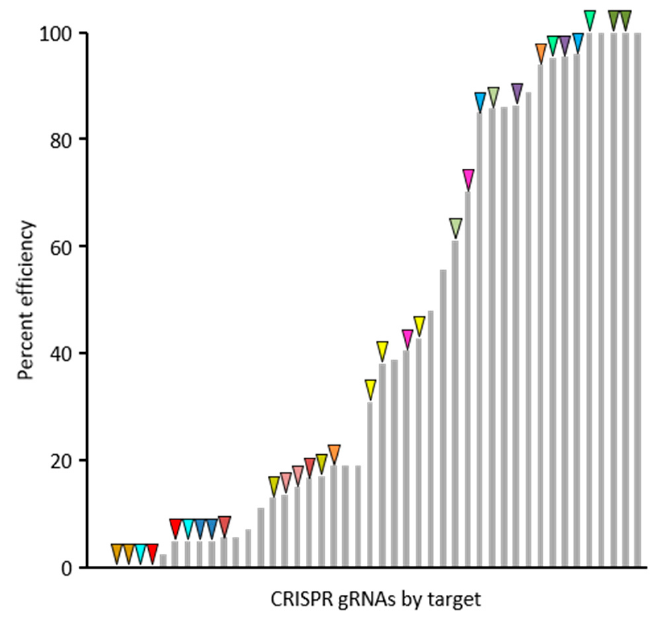
Figure 2. Efficiency rates of 30 gRNAs in maize. The proportion of target alleles edited in T 0 plants varies widely by gRNA and target, though the distribution of efficiency rates is skewed towards the extremes, with 39% of gRNAs tested having less than 15% efficiency and 30% having greater than 85% efficiency. Guide RNAs that target multiple genes (indicated by same-color triangles) tend to show similar efficiency rates for each target, indicating that gRNA efficiency is largely determined by characteristics of the gRNA itself and less so by characteristics of the target sequence.